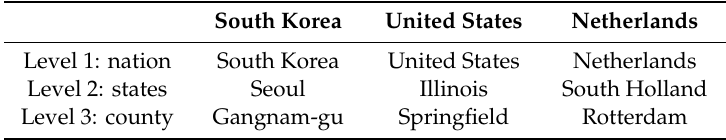
Table 1. Examples of the subdivision of administrative districts in South Korea, the United States, and the Netherlands provided by the Global Administrative Areas